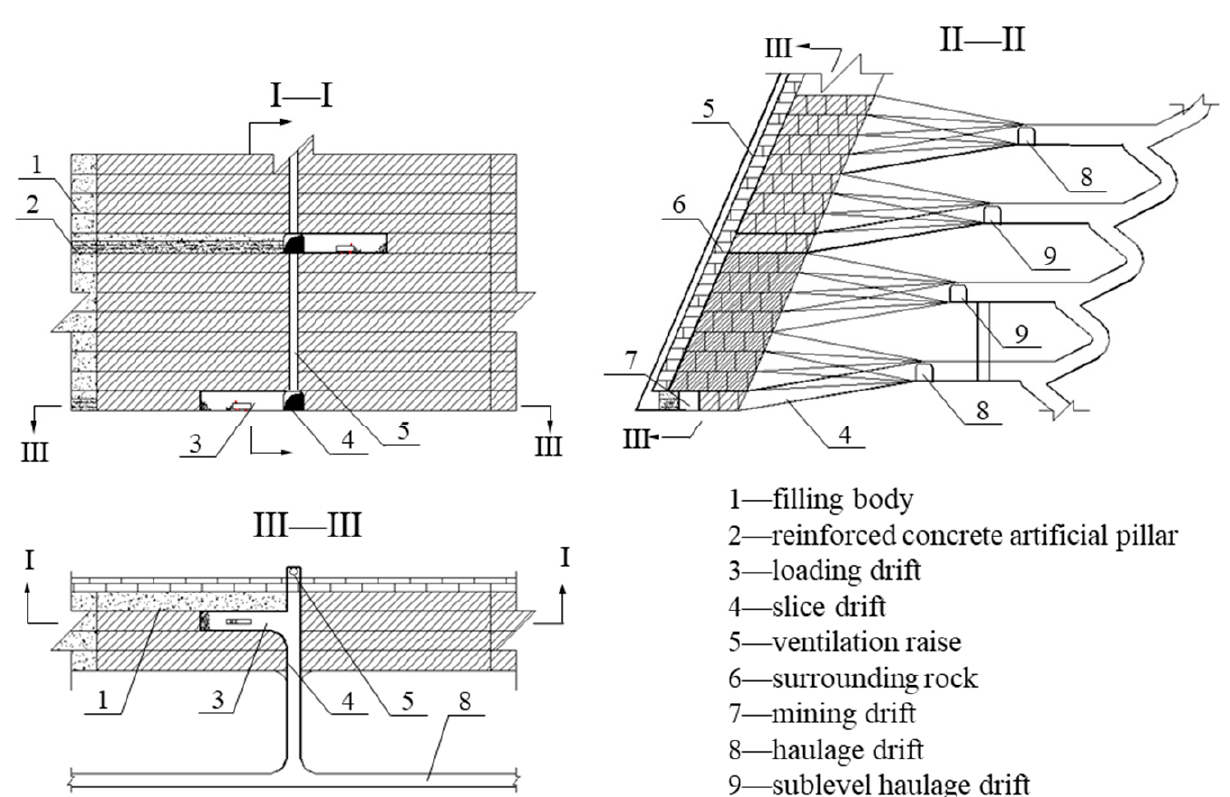
Figure 5. Schematic of the upward drift and cemented fill method. The underground mining has induced surface deformation and cracking (Figure